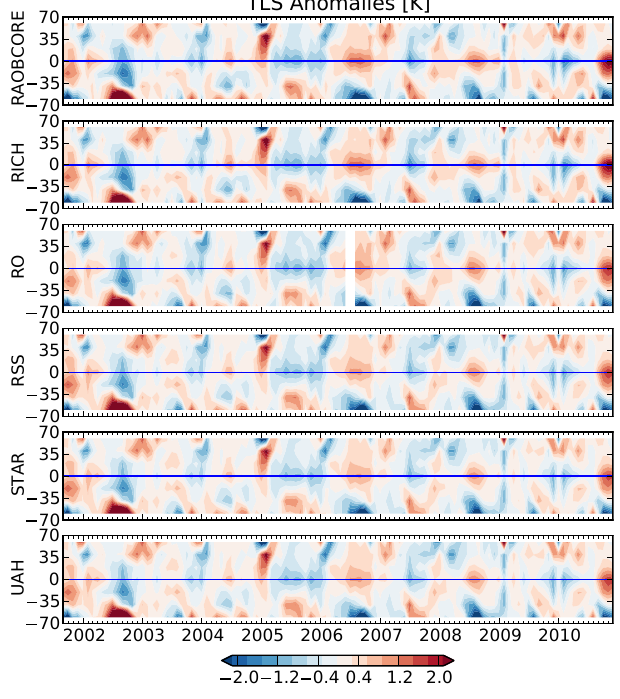
Fig. 7. Evolution of TLS anomalies for radiosondes (RAOBCORE, RICH), RO, and (A)MSU (RSS, STAR, UAH) (top to bottom), shown at 20 ◦ resolution.